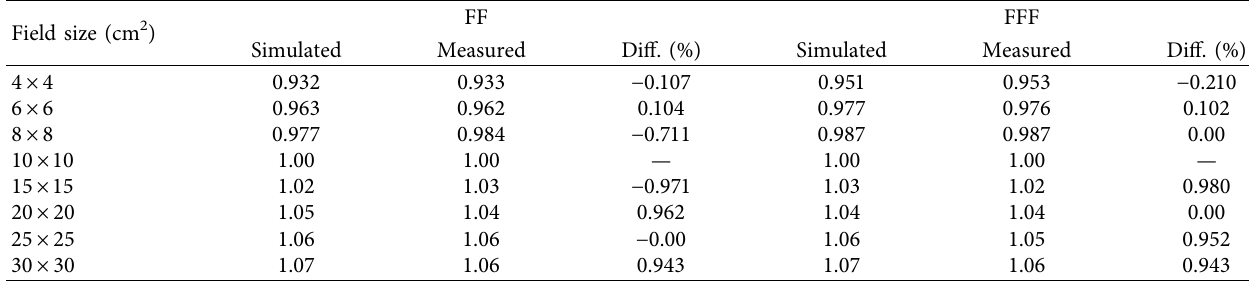
Table 6: The simulated and measured S c,p values for various field sizes at the depth of simulated S c,p values in FF mode of 4 × 4, 6 × 6, 8 × 8, 10 × 10, 15 × 15, 20 × 20, 25 × 25, 30 × 30cm 2 fields were as follows: 0.3%, 0.3%, 0.4%,